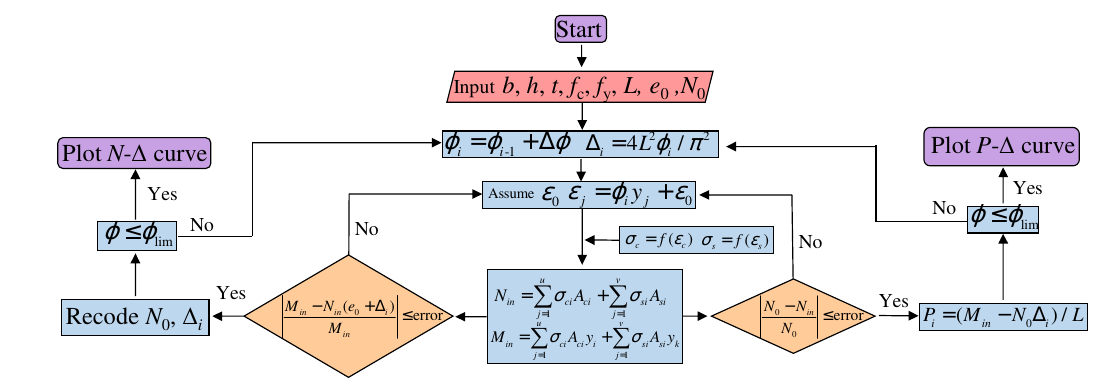
Figure 5. The flow diagram of calculation.